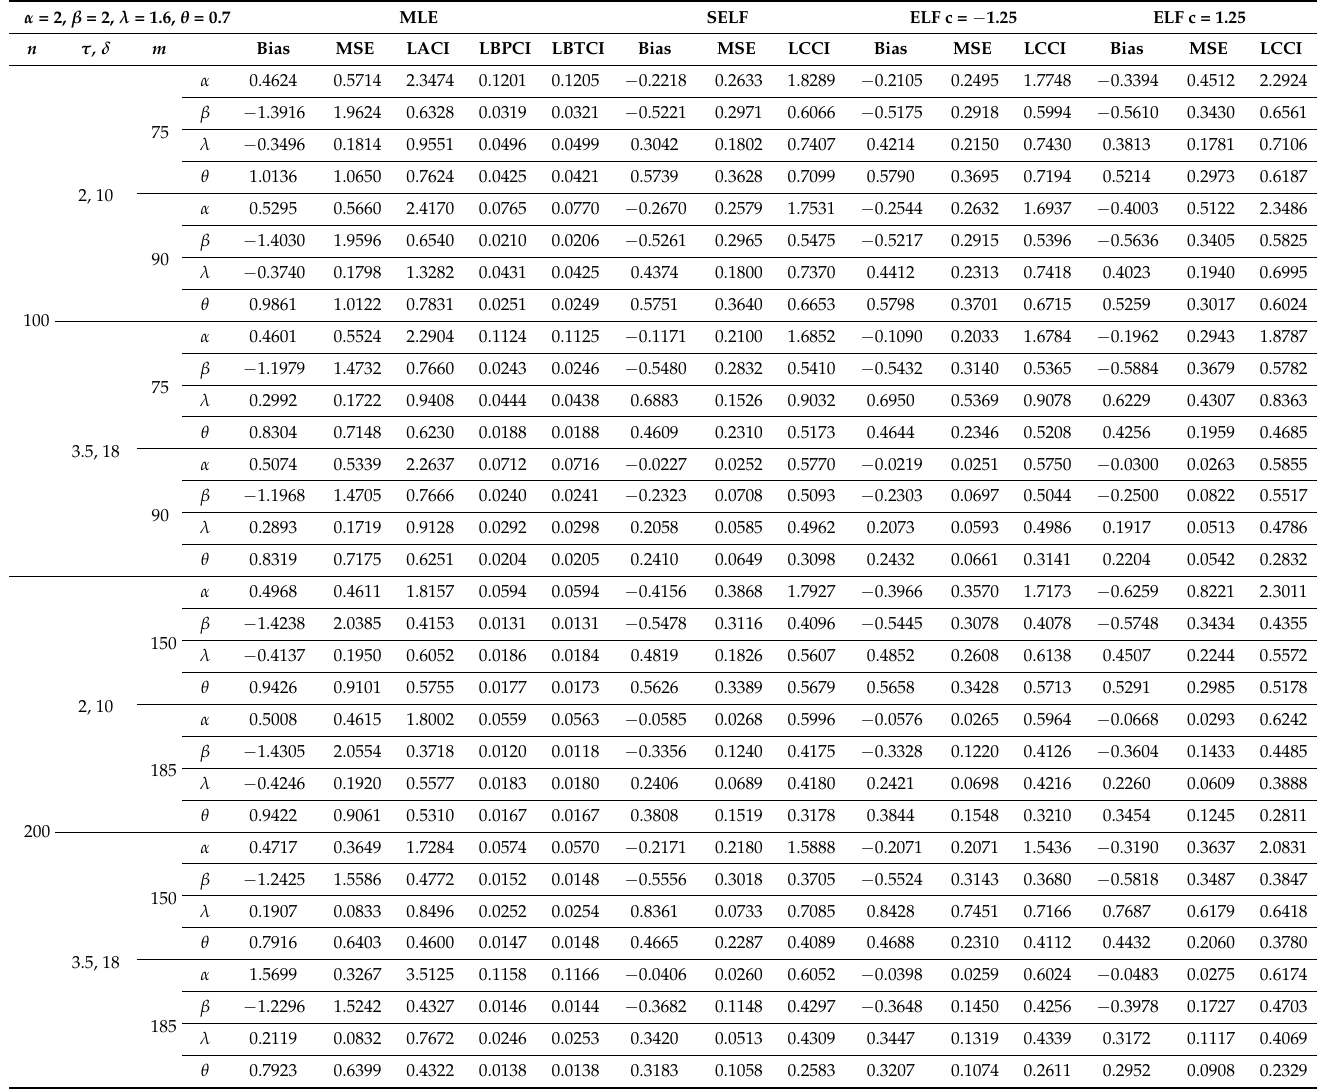
Table 3. Bias, MSE, LACI, LBCI, and LCCI with scheme 2 in case 1.